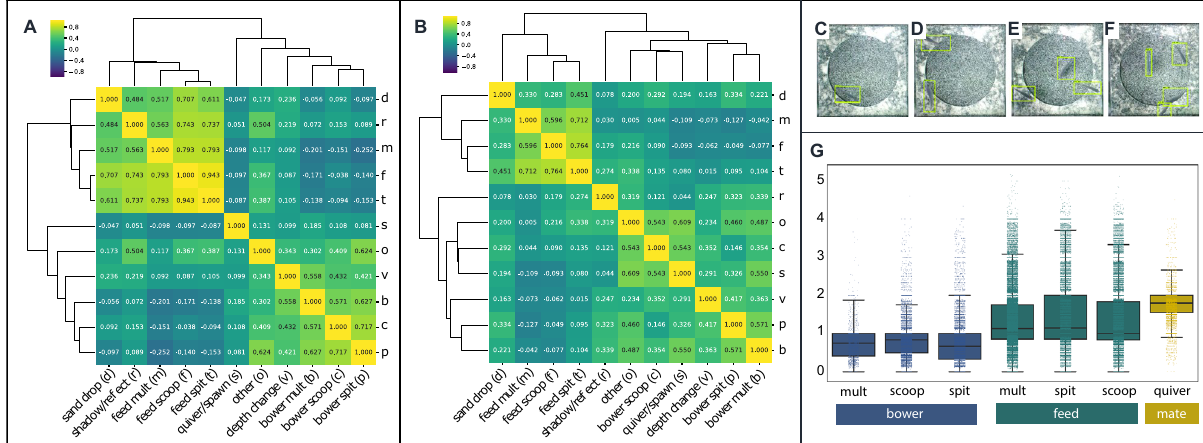
Figure 6. Temporal and spatial covariance among depth change, bower construction, feeding, and spawning. Hierarchical clustering of depth change and 3D ResNet-predicted behavioral events through time reveals three largely distinct behavioral clusters corresponding to feeding (left-most columns), bower construction (right- most columns), and quivering behaviors (middle column, ( A ); Pearson’s R values shown for each pairwise correlation). Quivering was more strongly and positively correlated with bower construction than with feeding. A similar analysis of the spatial distributions of depth change and behavioral events across the sand surface revealed two major clusters, one corresponding to feeding (left-most columns), and the other corresponding to quivering and construction behaviors (right-most columns; ( B )) notably, quivering was strongly spatially correlated but weakly temporally correlated with bower construction behaviors. To analyze social context, we used object recognition to detect and count fish above the sand tray during different behaviors, with green outlines indicating predicted fish ( C – F ); 1, 2, 3, and 4 fish detected, respectively). Analysis of the number of fish present above the sand tray during 3D ResNet-predicted behavioral events revealed strong differences in fish count across behavioral categories (( G ); p < 2.2 × 10 –16 ). Fish counts were lowest during bower construction, greater during feeding, and greatest during spawning, supporting dynamic and interrelated behavioral and social contexts across whole trials. Pearson’s R values are shown for each pairwise comparison, and the significance of each pairwise comparison and corresponding p-values can be found in Supplementary Tables S1 and S2. Letter abbreviations for each behavioral measure are indicated in the labels along the horizontal R = 0.717, p < 2.0 × 10 –16 , Fig. 6A) and between feeding scoops and spits (Pearson’s R = 0.943, p < 2.0 × 10 –16 , Fig. 6A), but negative correlations between construction behaviors and feeding behaviors (bower scoop versus feed scoop, Pearson’s R = − 0.03802, p = 0.33; bower scoop versus feed spit, Pearson’s R = − 0.09374, p = 0.017; bower spit versus feed scoop, Pearson’s R = − 0.14039, p = 3.4 × 10 –4 ; bower spit versus feed spit, Pearson’s R = − 0.15271, 9.75 × 10 –5 , Fig. 6A). Taken together, these data suggest that construction is expressed at different times than feeding. Unexpectedly, we found quivering was relatively weakly correlated with both feeding (quiv- ering versus feed scoop, Pearson’s R = − 0.09665, p = 0.014; quivering versus feed spit, Pearson’s R = − 0.08741, p = 0.026, Fig. 6A) and construction behaviors (quivering versus bower scoops, Pearson’s R = 0.1077, p = 6.14 × 10 –3 ; quivering versus bower spits, Pearson’s R = 0.080532, p = 0.041, Fig. 6A). In contrast to our predictions, these data suggest that quivering behaviors are expressed largely independently of bower construction behaviors through time. A complete list of Pearson’s R values and p-values for each pairwise relationship among behavioral categories can be found in Table S1.